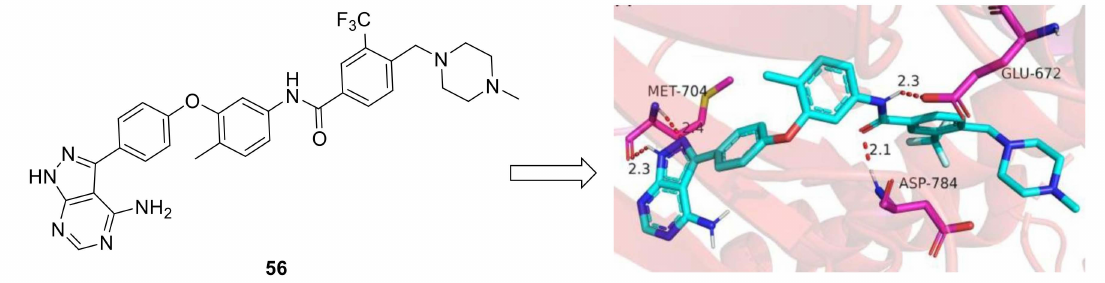
Figure 24. Chemical structure of compound 56 and its docking model to DDR1 active site. Reprinted with permission from Ref. [157].